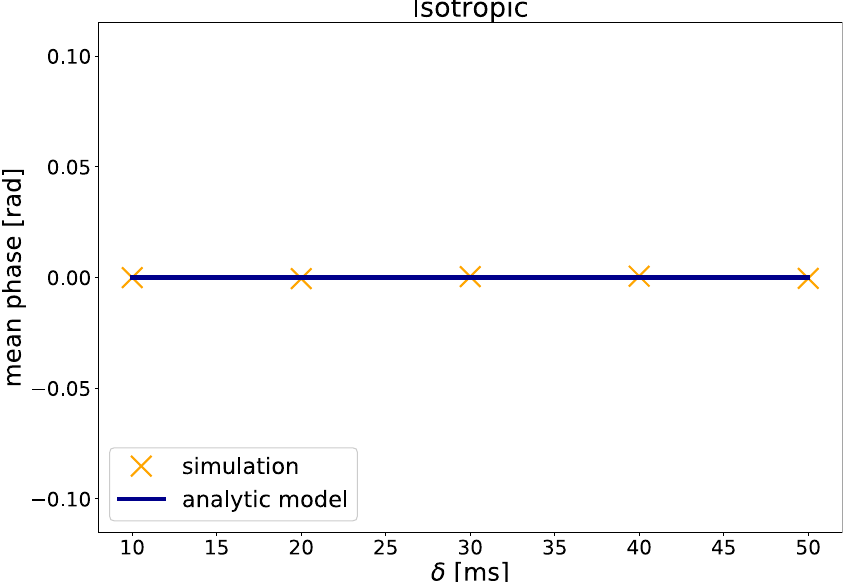
Fig 2. The results of the validation simulation A1: The mean net phase versus the duration of the gradient pulse δ for isotropic diffusion.